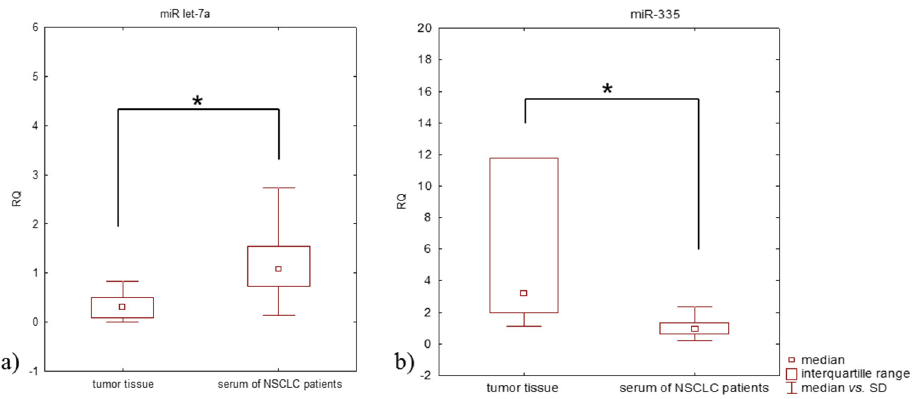
Figure 2. Box plot showing differences in median RQ values for ( a ) miR let-7a, ( b ) miR-335 in tumor tissue and in serum of NSCLC patients; * p < 0.05.